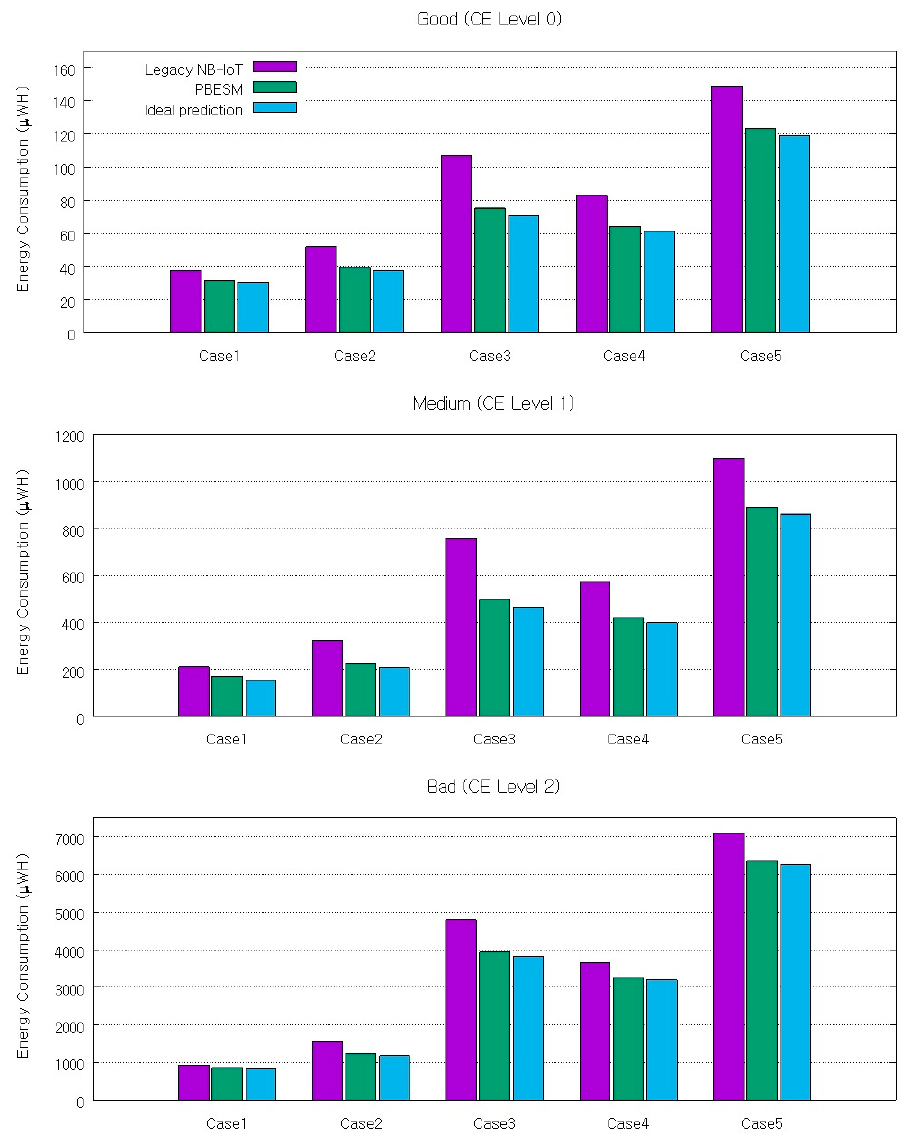
Figure 15. Energy consumption according to channel condition for legacy NB-IoT, PBESM, and ideal prediction.